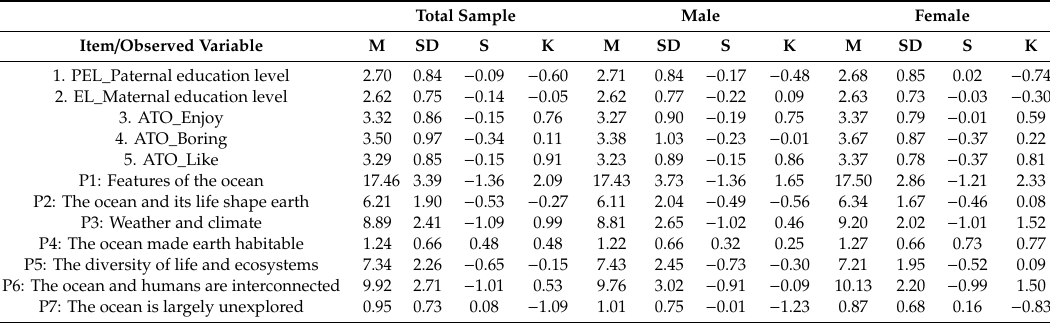
Table 1. Descriptive statistics of all observed